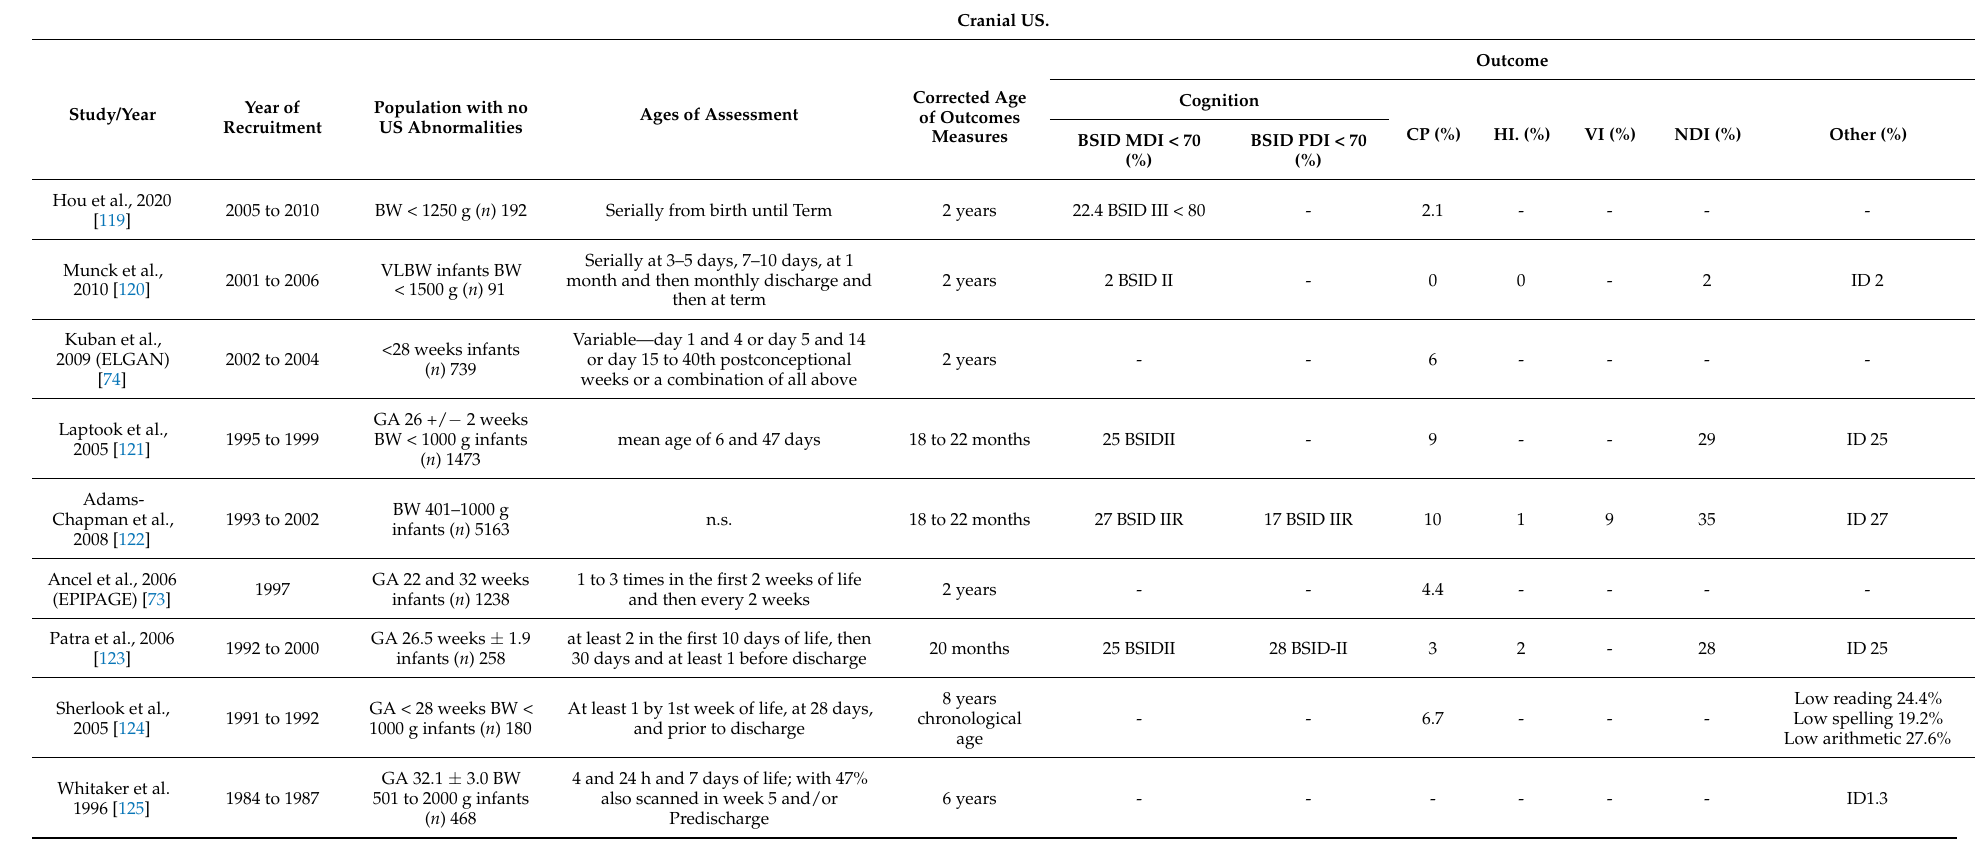
Table 4. Normal neonatal imaging (Cranial US and TEA MRI) exam and neurodevelopmental outcomes in preterm infants. Cranial